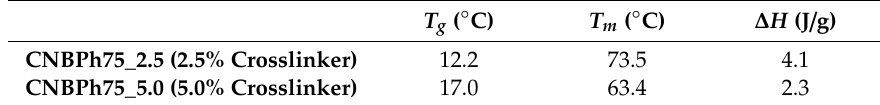
Table 1. Phase transitions for CNBPh75_2.5 and CNBPh75_5.0 membranes determined via